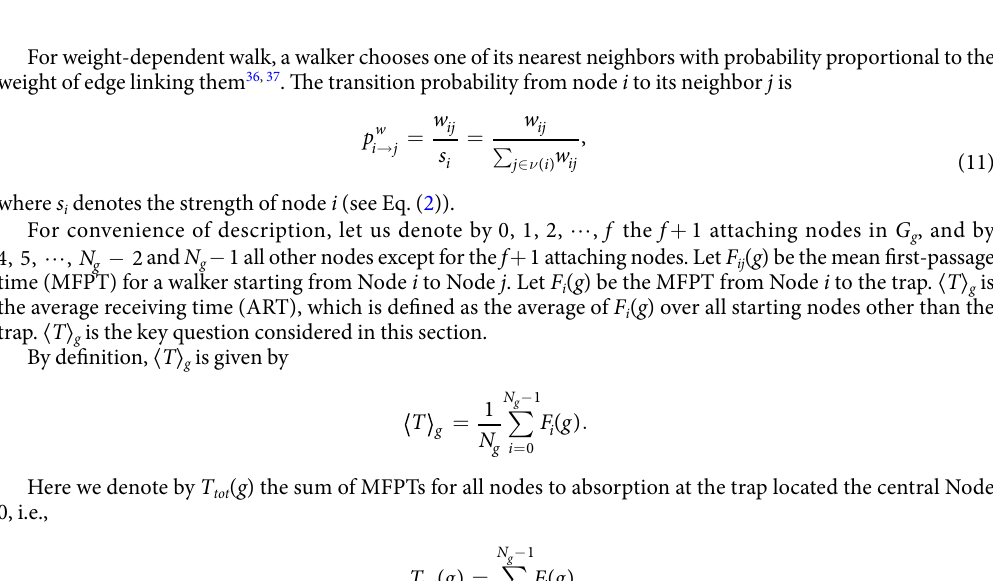
Figure 4. The average weighted shortest path. Plot of the renormalized average weighted shortest path =∼ − versus the iteration g , where